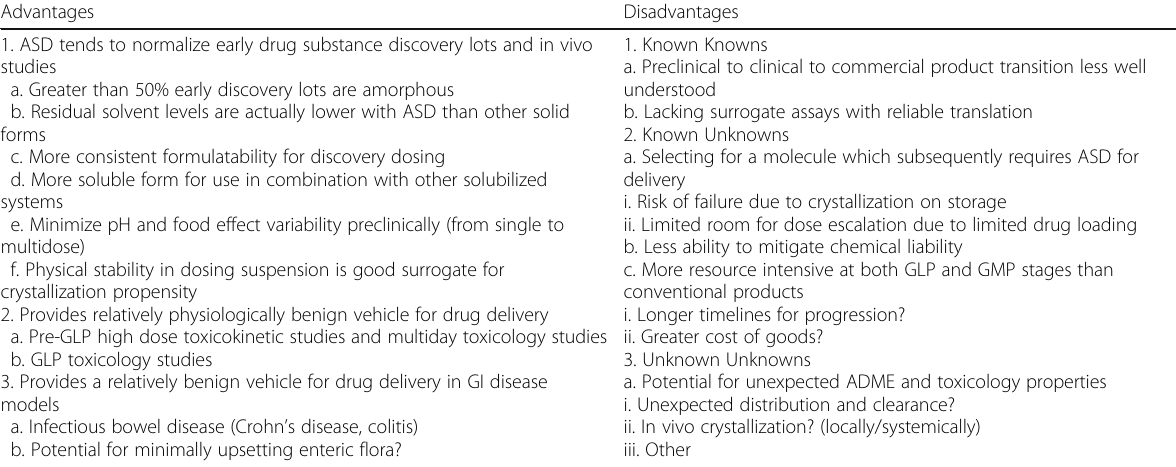
Table 1 Advantages and disadvantages of ASDs in drug